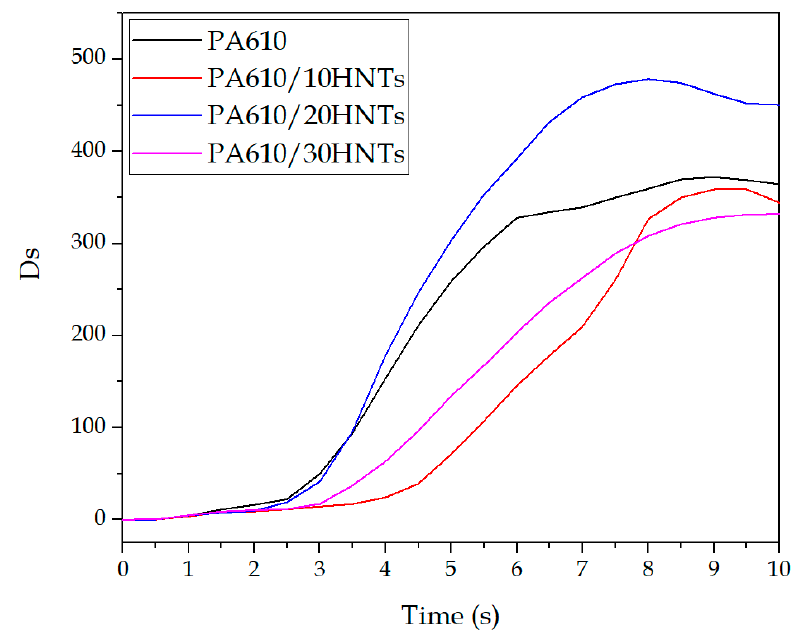
Figure 10. Evolution of optical density as a function of time.